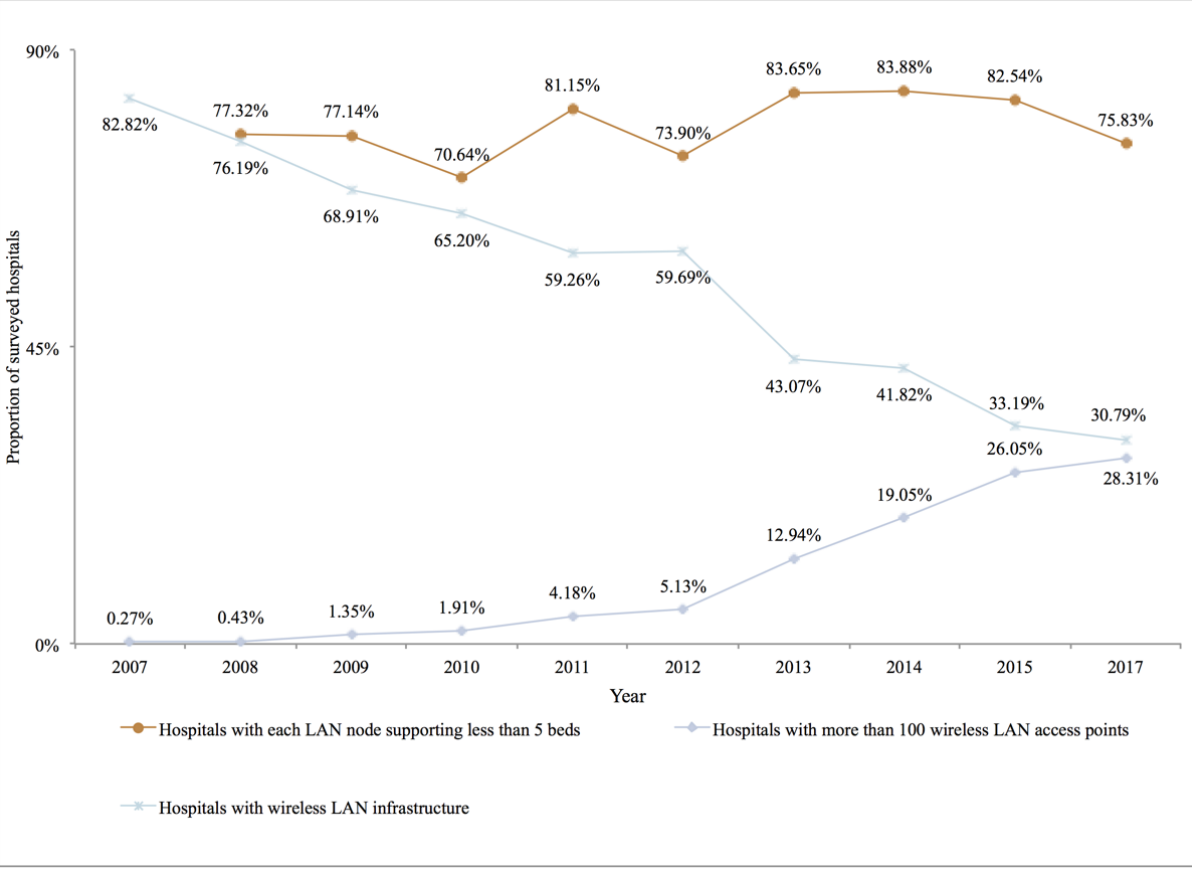
Figure 10. The construction and implementation of